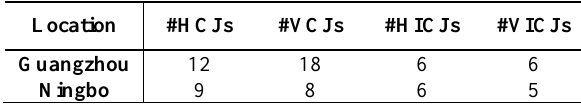
Table 3. The number of HCJs, VCJs, HICJs, and VICJs.